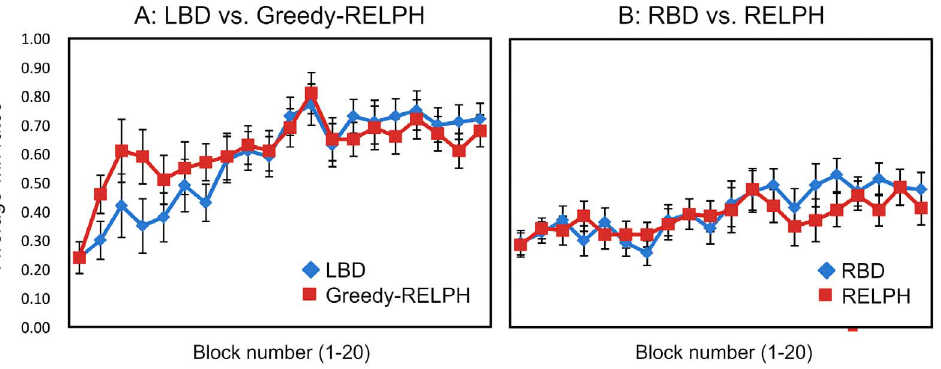
Figure 2. The average win rate for patient groups versus RELPH. Each plot represents the average win rate for (A) greedy-RELPH and (B) RELPH, (red lines) against the average win rate of (A) LBD, (B) RBD patients (blue lines) over the last 200 trials in the RPS experiment of Danckert et al. [13]. Error bars represent the standard error of the mean.